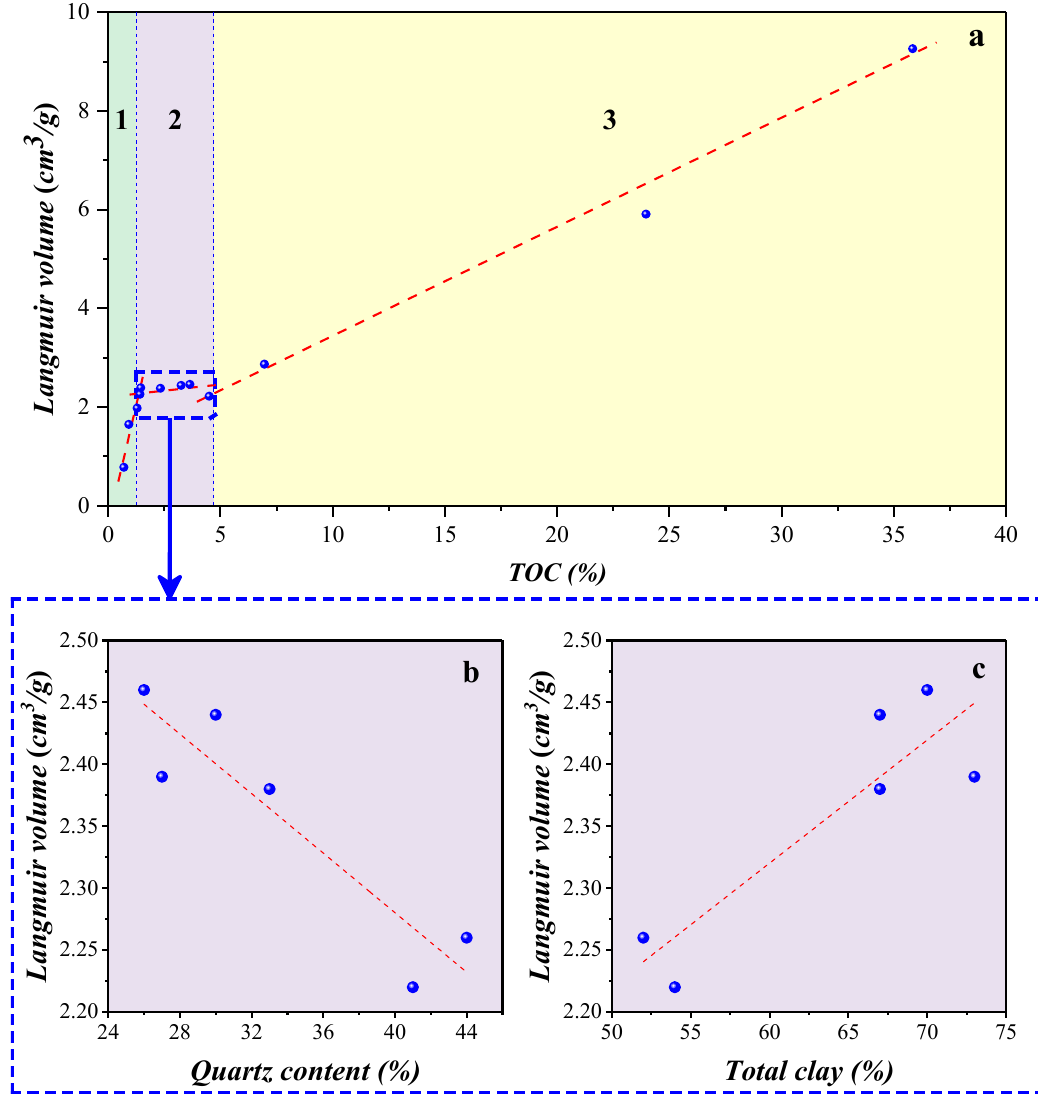
Figure 13. ( a ) Relationship between methane adsorption capacity and TOC content for the 12 shale samples; ( b ) relationship between methane adsorption capacity and quartz content for the shale samples whose TOC content is 1.4–4.5%; and ( c ) relationship between methane adsorption capacity and total clay content for the shale samples whose TOC content is 1.4–4.5%.